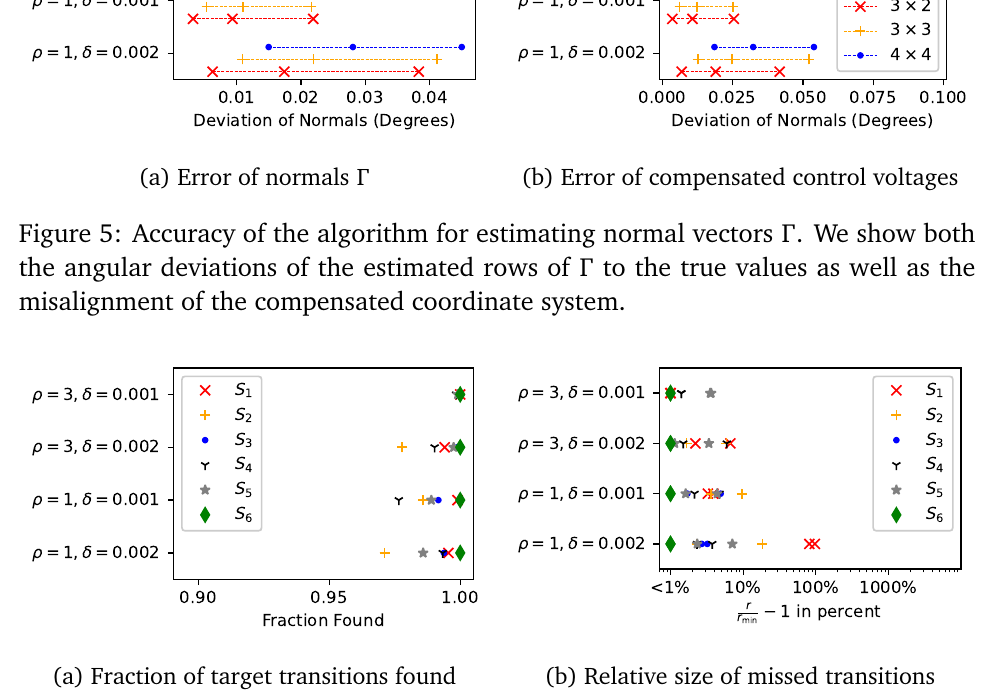
. Left: fraction of facets n